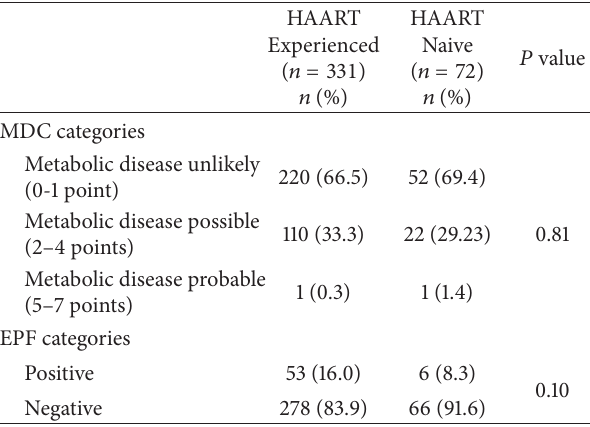
Table 2: Demographics. Table 3: MDC and EPF total scores.